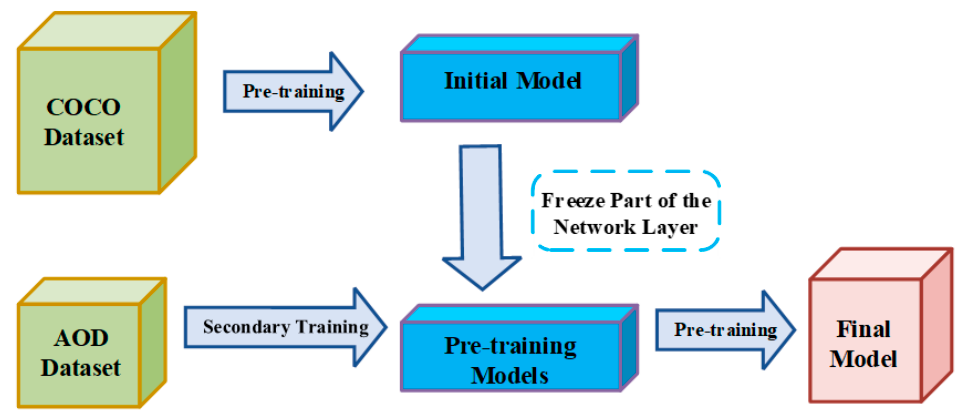
Figure 8. Transfer learning process.